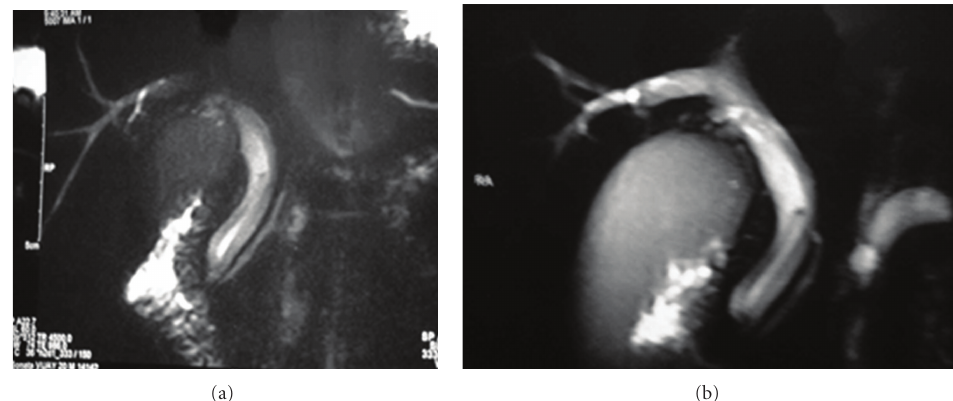
Figure 2: (a) MRCP—hypointense tubular filling defect in CBD and CHD. (b) CBD—9mm GB—distended, wall thickening and luminal sludge.